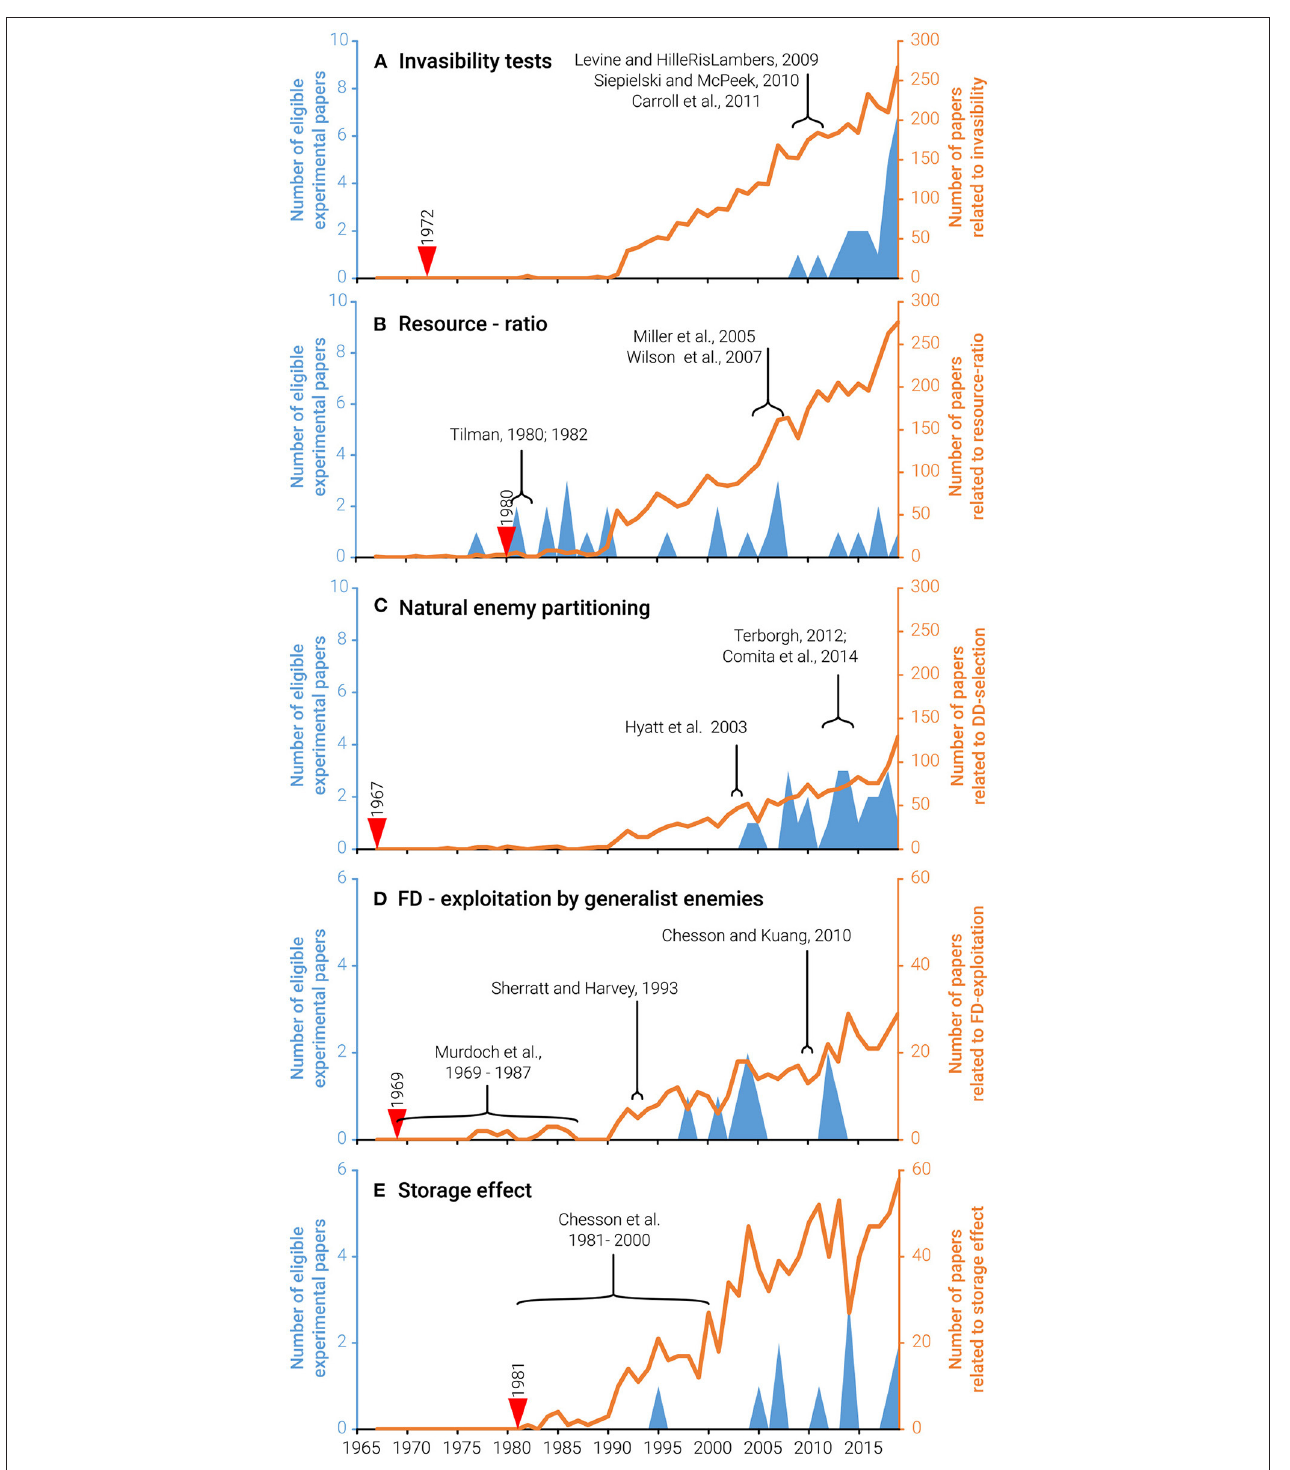
FIGURE 1 | Literature trends, reflecting the lack of experimental coexistence studies. General interest in the coexistence topics that we chose (orange (orange lines, right axis) and the experimental studies that our review selected as eligible (blue areas, left axis) is still increasing. However, for each topic-year combination, the eligible experimental studies constitute less than 2% of the published pool. We chose five core topics, namely, invasibility tests for coexistence (A) and mechanisms allowing invasibility, i.e., resource-ratio (B) , natural enemy partitioning (C) , frequency-dependent exploitation by a generalist enemy (D) , and the storage effect (E) . The starting year of each literature survey and the influential papers that were used as a basis for the literature search are indicated by red arrows and elongated black brackets ,